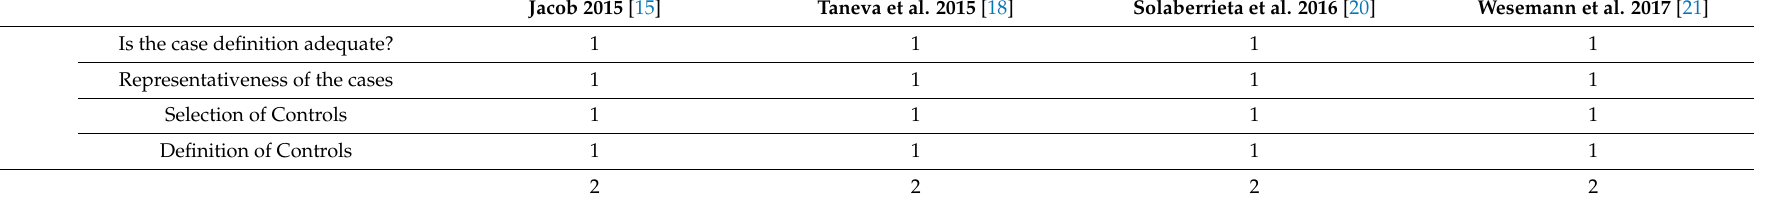
Table 3. Evaluation of case—control studies according to Newcastle—Ottawa quality